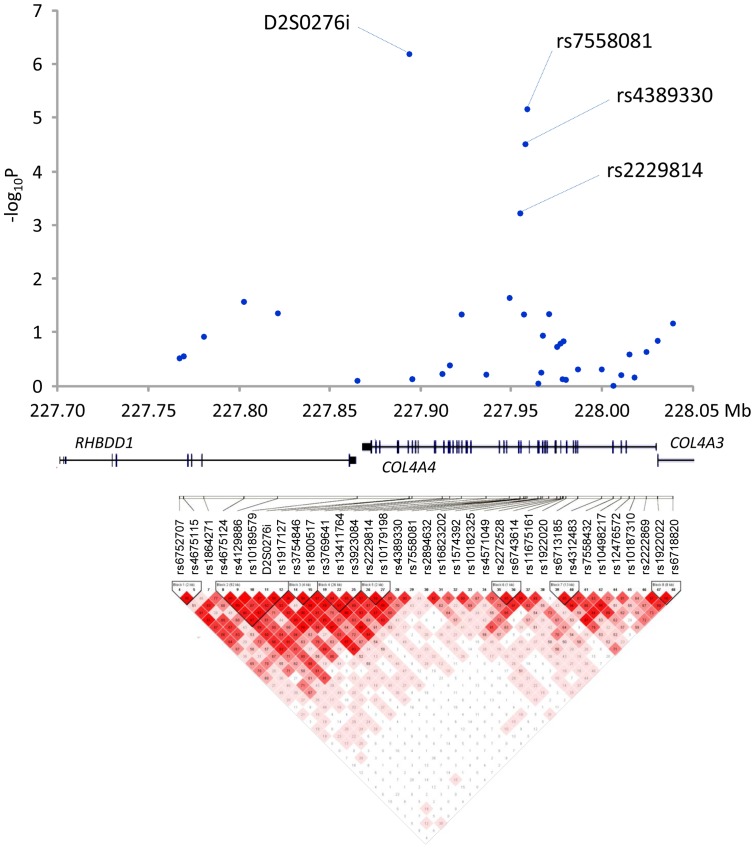
Association analysis of single nucleotide polymorphisms (SNPs) across the COL4A4 and RHBDD1 gene regions in 574 patients and 608 controls.The upper panels depict distribution of association results of D2S0276i and SNPs in COL4A4 and RHBDD1. The results of monomorphic SNPs are not shown. The lower panels show the linkage disequilibrium structure in the COL4A4 and RHBDD1 regions; brighter red indicates higher D’.